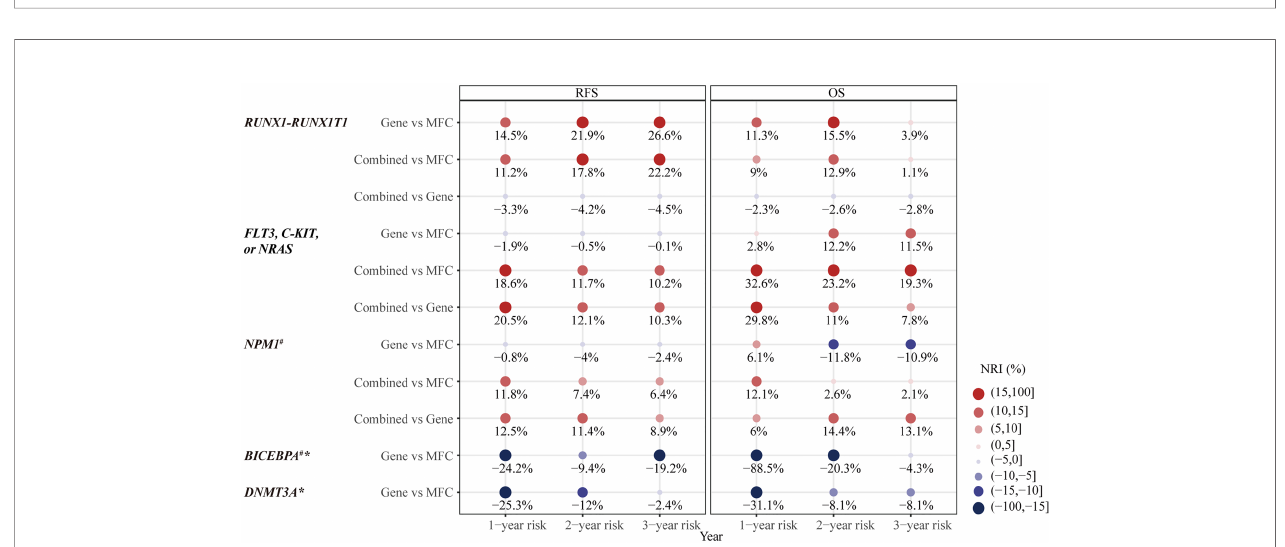
FIGURE 3 | The category-based net reclassi fi cation improvement (NRI) of prediction on relapse-free survival (RFS) and overall survival (OS) by MRD status in different types of AML-related genetic lesions. # Notice, there were less than three people in Gene + group. *no signi fi cant difference in prognosis predicted by Gene MRD and therefore no combination of MFC MRD and Gene MRD. NRI, net reclassi fi cation improvement; MFC, multicolor fl ow cytometry; MRD, measurable residual disease; Combined MRD, MRD positivity detected by either MFC or molecular method; RFS, relapse-free survival; OS, overall